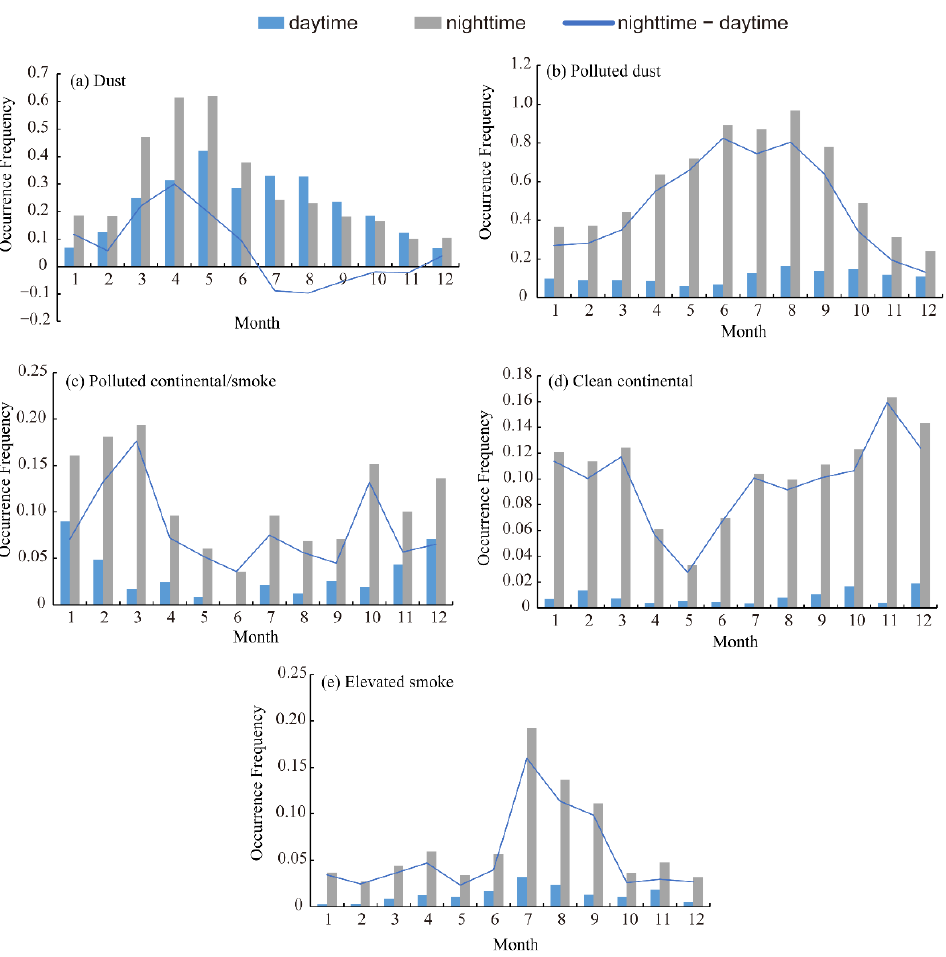
Figure 4. Monthly occurrence frequencies of five subtypes in the daytime and nighttime from 2007 to 2021: ( a ) dust; ( b ) polluted dust; ( c ) clean continental; ( d ) polluted continental/smoke; ( e ) elevated